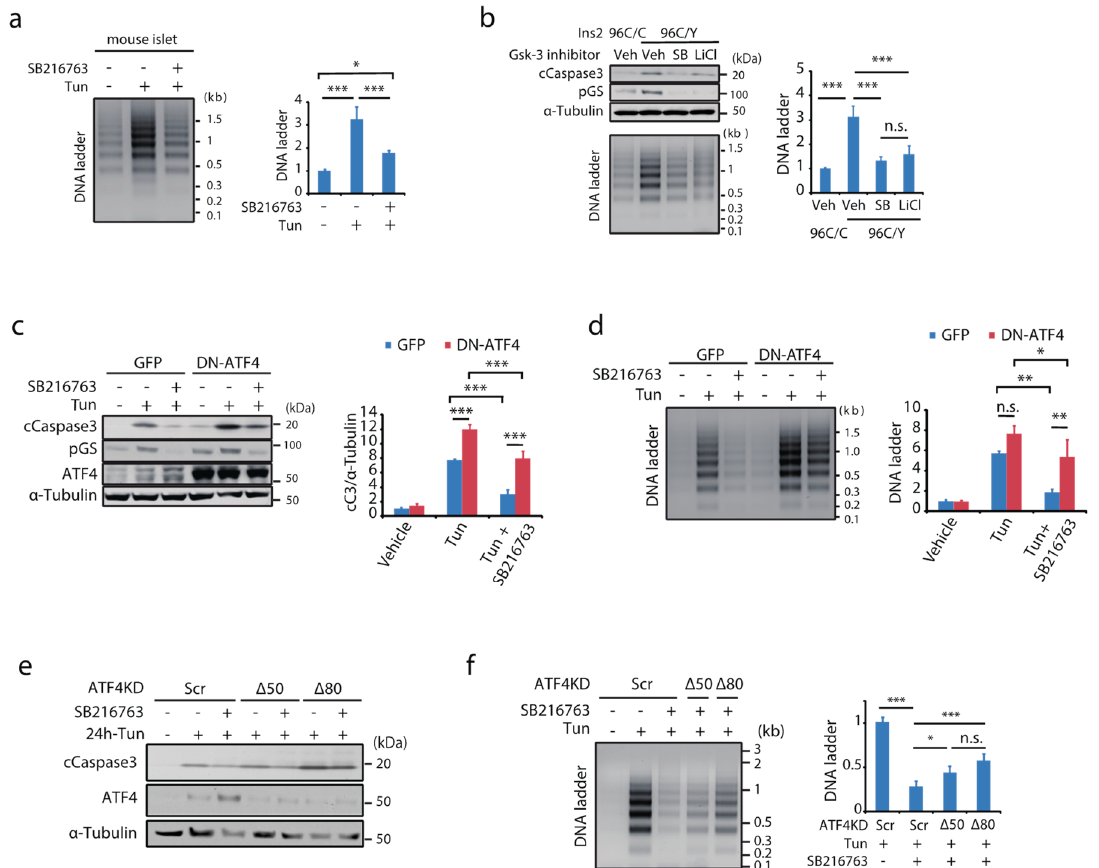
Figure 3. Inhibiting GSK-3 activity attenuates ER stress-induced apoptosis, dependently of ATF4. ( a ) DNA ladder assay in isolated islets incubated with tunicamycin for 20 h in the presence or absence of Gsk-3 inhibitor. Graphical data represent mean ± SD (n = 4). ( b ) Effects of Gsk-3 inhibition on serum deprivation-induced apoptosis in Ins2 96C/Y and Ins2 96C/C were assessed by detecting cleaved caspase 3 and DNA fragmentation. Graphical data are mean ± SD (n = 3). MIN6 stably expressing GFP or DN-ATF4 were incubated with tunicamycin for 20 h in the presence or absence of Gsk-3 inhibitor. ( c ) The protein lysates were analysed by Western blotting with indicated antibodies. Relative expression of cleaved caspase 3 is summarised in the graph (n = 3). ( d ) DNA ladder was examined. Relative amount of DNA ladder is expressed in the graph (n = 3). The effect of knock down of ATF4 ( Δ 50, Δ 80) on anti-apoptotic action of Gsk-3 inhibition was examined in MIN6. ATF4 was knocked down by inducing shRNA targeting two distinct sequences of mouse ATF4. Following the ER stress treatment in the presence or absence of the Gsk-3 inhibitor, ( e ) expression of cleaved caspase 3 and ( f ) DNA ladder was examined. The graphs represent the relative abundance of the DNA ladder (n = 3). All statistical data were assessed by one-way ANOVA followed by Bonferroni’s post hoc test, * p < 0.05, ** p < 0.01, *** p < 0.001. n.s., not significant. 2.6. Gsk-3 Modulates Integrated Stress Response ATF4 is a key mediator of ISR during adaptation to ER stress [17,31,32]. The effects of Gsk-3 inhibition on the upstream and downstream regions of ATF4 were examined in MIN6 cells. eIF2 α -S51 was similarly phosphorylated by a 4 h tunicamycin treatment, whereas it declined after 8 h in MIN6 cells where Gsk-3 was inhibited (Figure 4a,b and Supplementary Figure S4a). Simultaneously, the expression of GADD34, a transcriptional target of ATF4, was significantly increased, implying that dephosphorylation of eIF2 α was facilitated (Figure 4a,b and Supplementary Figure S4a). In addition, the induction of 4E-BP1, another transcription target, was significantly enhanced by Gsk-3 inhibition (Figure 4a,c and Supplementary Figure S4a,b). The effects of Gsk-3 inhibition on eIF2 α and 4E-BP1 expression were abolished by the introduction of DN-ATF4 (Figure 4d,e).